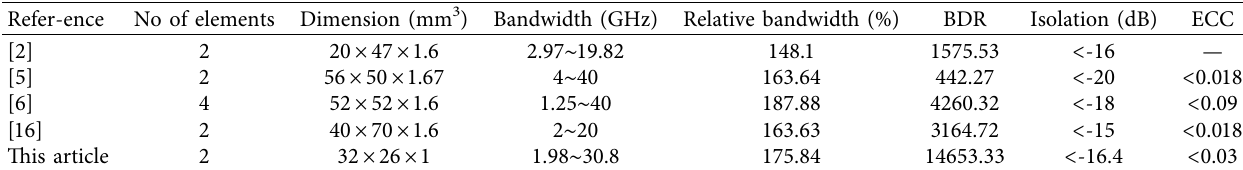
Figure 15: ECC simulation and real testing. Table 1: Performance of the proposed SWB-MIMO antenna and referenced